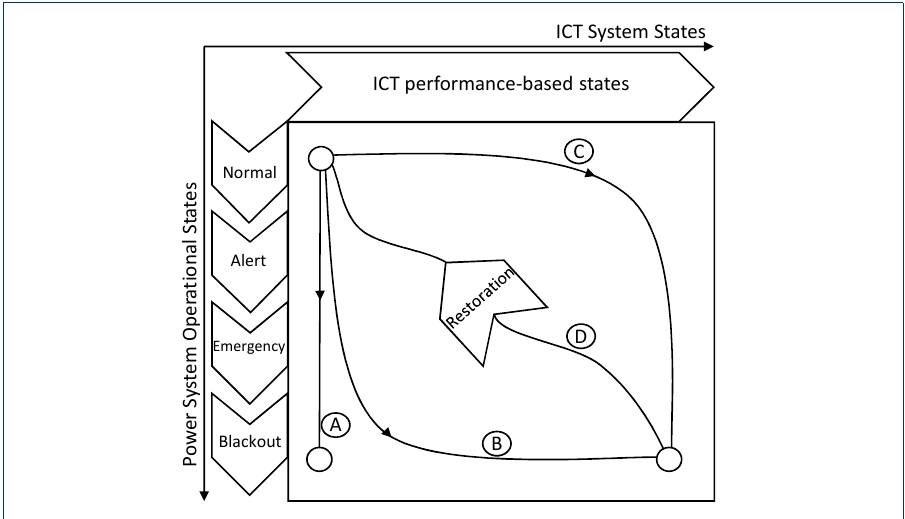
Figure 1 Concept of Joint State Classi(cid:12)cation